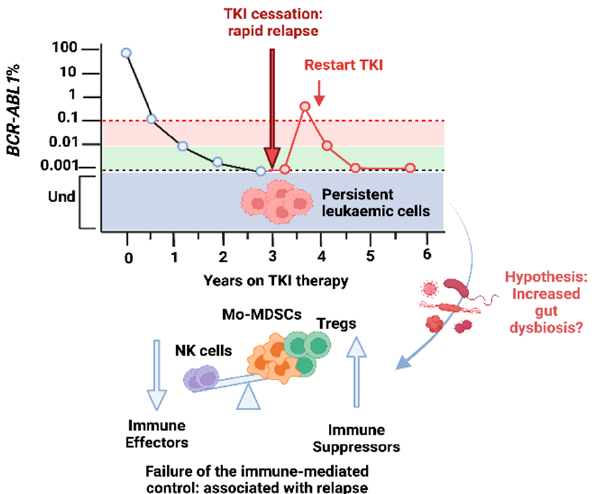
Figure 2. Molecular relapse in Chronic Myeloid Leukaemia (CML) after cessation of the Tyrosine Kinase Inhibitor (TKI) therapy. The response to TKI therapy is assessed by measuring the levels of BCR-ABL1 transcript in the blood by a conventional real-time quantitative reverse transcription PCR and through the achievement of molecular milestones over the time of therapy. Major molecular response (in red) is defined by BCR-ABL1 ≤ 0.1% and deep molecular response (in green) is defined by BCR-ABL1 ≤ 0.01% or lower. Samples with BCR-ABL1 mRNA levels less than 0.001% are considered undetectable (in grey), and this is the limit of detection of the method. With prolonged TKI therapy some patients have no longer detectable BCR-ABL1 mRNA. Patients under TKI therapy for at least 3 years and in deep molecular response (green) for at least 2 years can cease their TKI to attempt treatment-free remission (black line). About 50% of patients who cease TKI therapy have a rapid molecular relapse, defined as loss of major molecular response (red line) and need to resume their TKI. More than 90% of them achieve again deep molecular response (green). Disease recurrence may be explained by the persistence of residual leukaemia cells not eradicated by the therapy, which provide a source of relapse and a bottleneck to cure. Growing evidence indicates the failure of the immunological surveillance of the residual CML cells associated with relapse. Gut dysbiosis is hypothesized to be involved in the creation of the immunosuppressive microenvironment which sustains cancer progression and relapse. NK cells: natural killer cells; T regs: FOXP3+ Regulatory T cells; mo-MDSCs: monocytic myeloid-derived suppressor cells. Created with BioRender.com. Licence obtained on 14 March